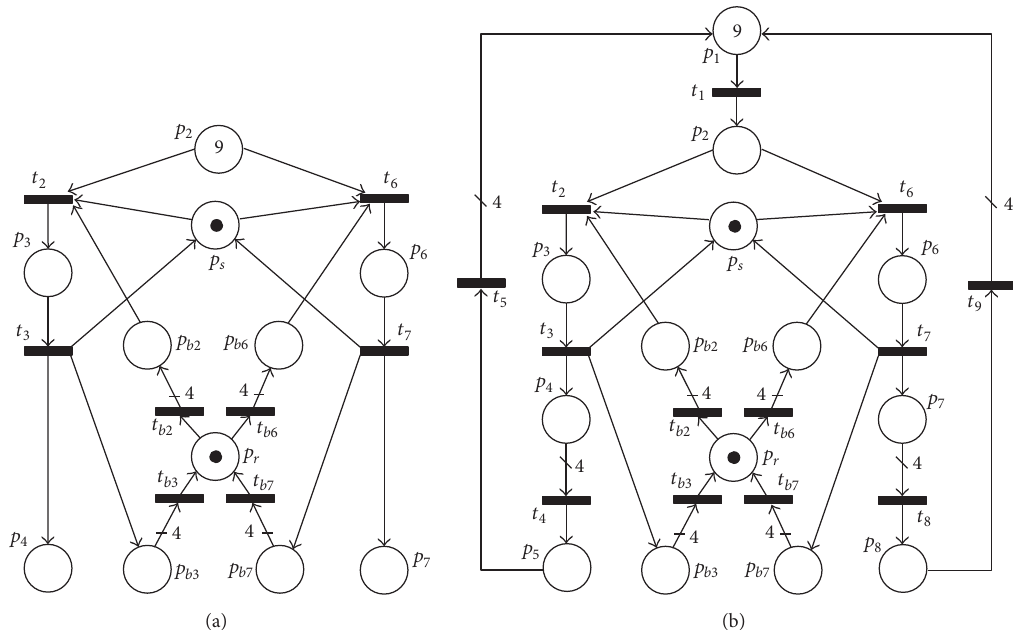
Figure 9: (a) The enhanced MESR 𝑁 𝐶 with dispersive pattern and (b) the complete control system with periodic mutual exclusion supervisor 𝑁 𝑆